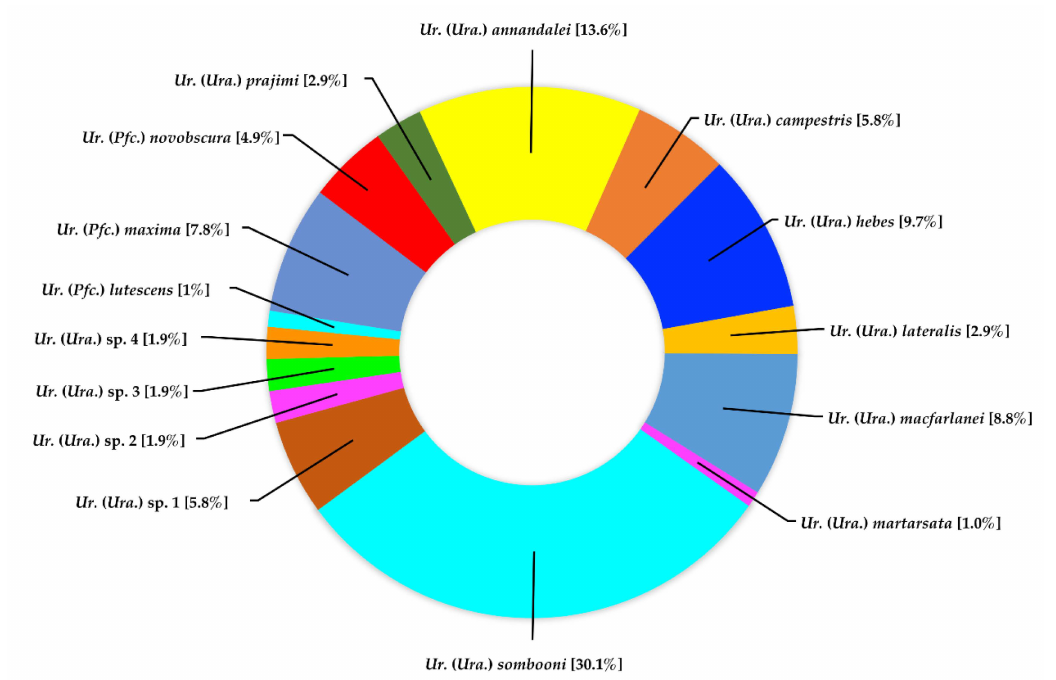
Figure 6. Species composition and abundance of mosquitoes of the genus Uranotaenia collected in Doi Inthanon National